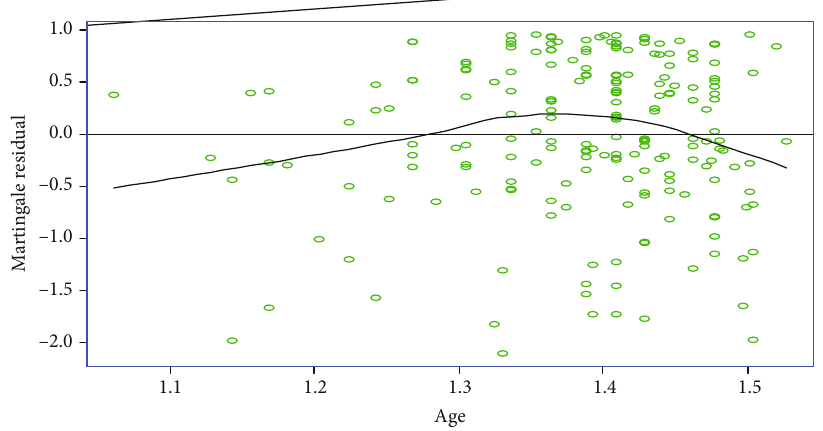
Figure 3: Plots of the martingale residuals against the covariate